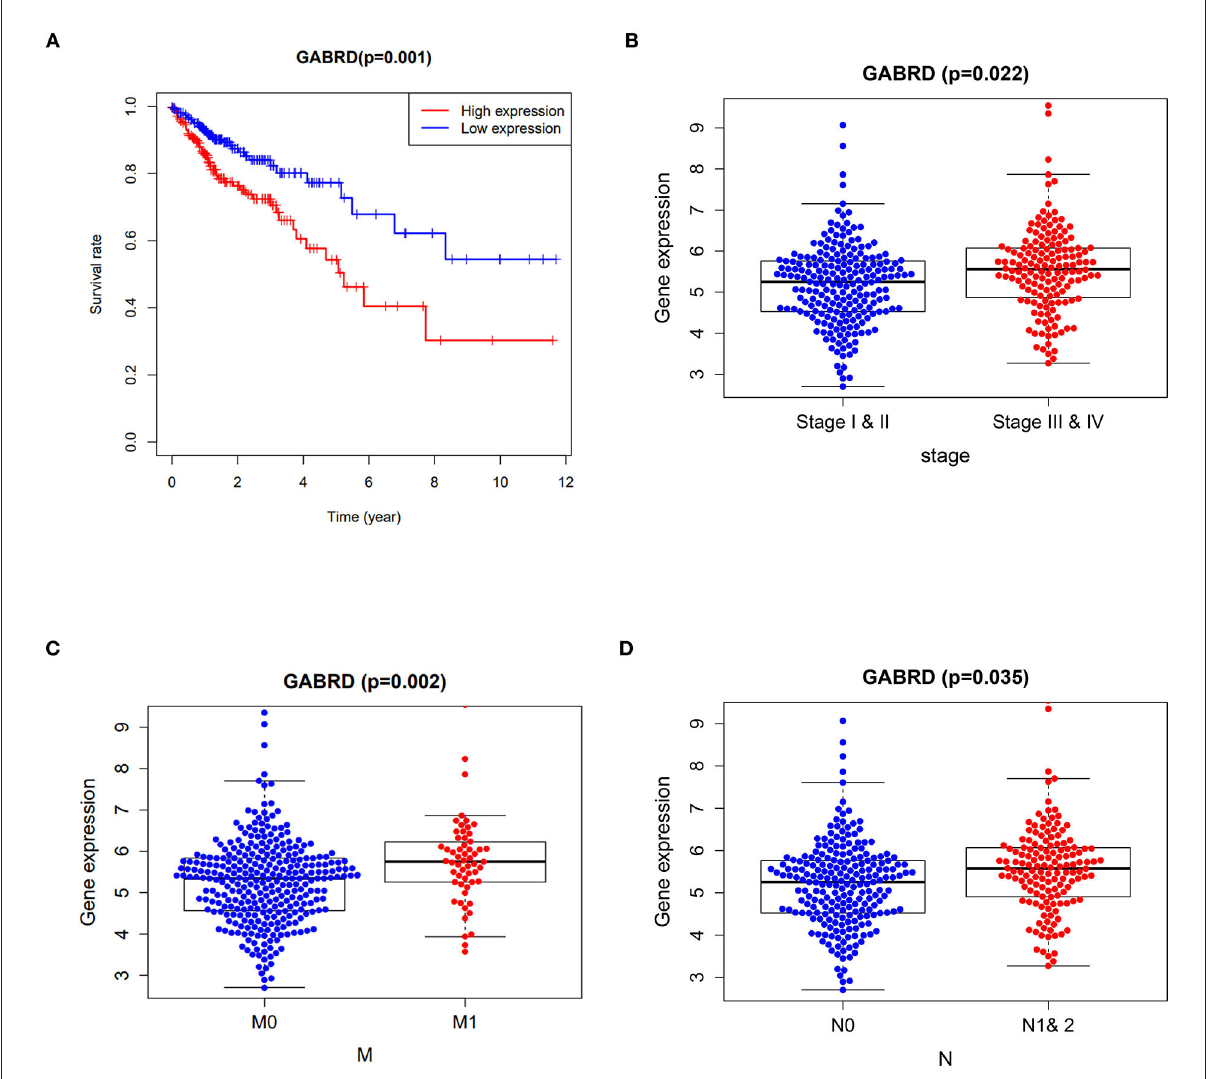
FIGURE2 Clinicopathological analysis of curcumol’s targets against COVID-19 and colon adenocarcinoma. (A) Survival analysis using the Kaplan–Meier estimator showed that the colon adenocarcinoma patients with higher expression of GABRD had poorer overall survival rates. Higher expressions of GABRD in colon adenocarcinoma patients are associated with (B) advanced stages, (C) metastatic tumors, and (D) a higher number of tumors spread to the lymph nodes. M0 means cancer has not spread to distant organs. M1 means cancer has spread to distant organs. N represents the number of lymph nodes containing the